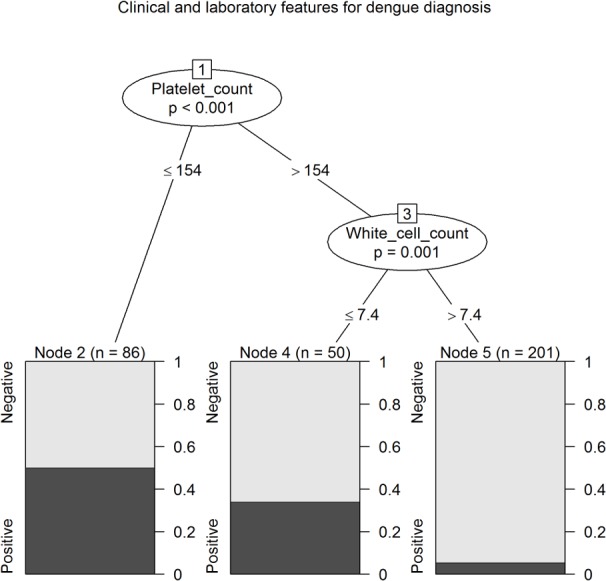
Conditional inference tree for the prediction of reference diagnosis of DENV infection using clinical features and laboratory parameters with an association (p<0.05) with the reference diagnosis of DENV infection (platelet levels and white cell levels; note the model removes clinical features from the tree).